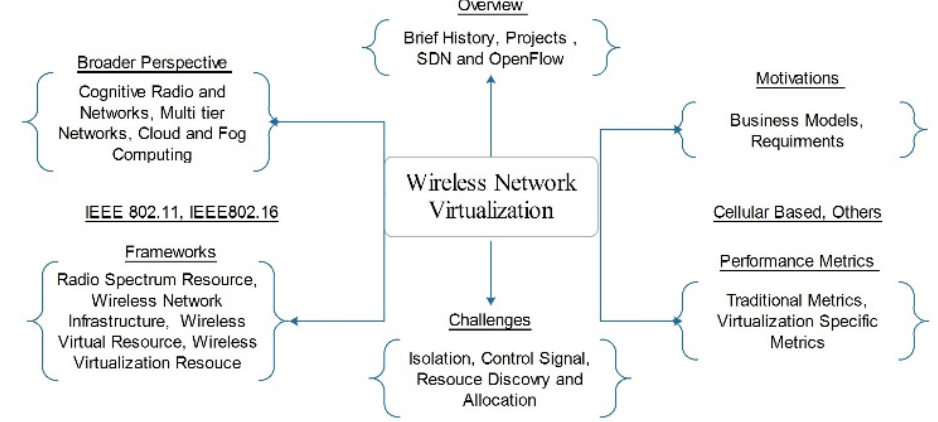
Figure 26. Wireless network virtualization.